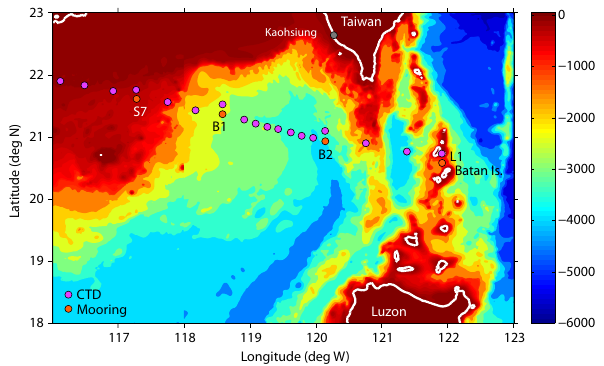
Fig. 1. Map showing asset locations during the WISE/VANS experiment from April 2005 to June 2006 in the South China Sea. The background color indicates bottom depth according to the color bar at right. The Batan Islands are on the eastern (Luzon) Ridge and the ridge south of Taiwan is the western (Heng-Chun)